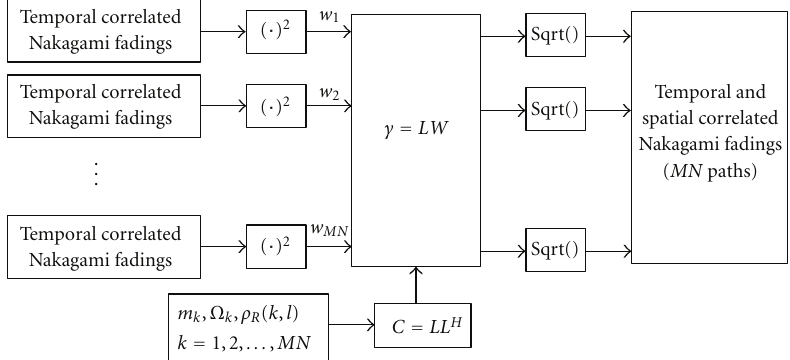
Figure 5: Introducing spatial correlation.